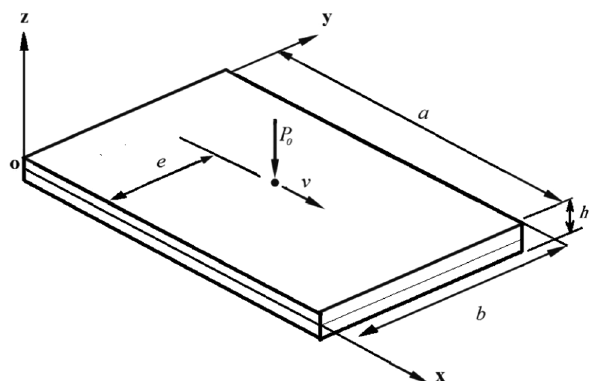
Fig. 1 Schematic of FGM plate excited by a moving